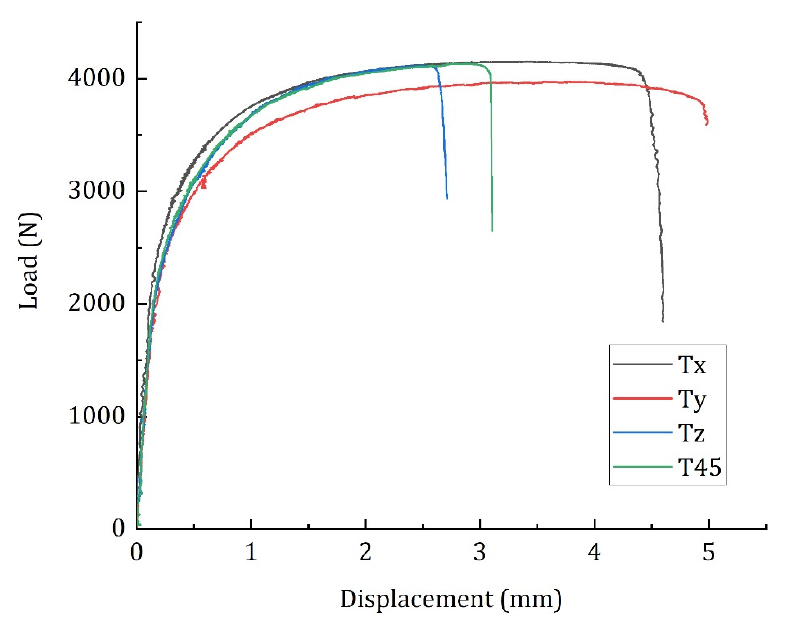
Figure 4. Load-displacement curves of the AlSi10Mg specimens built in four different orientations.